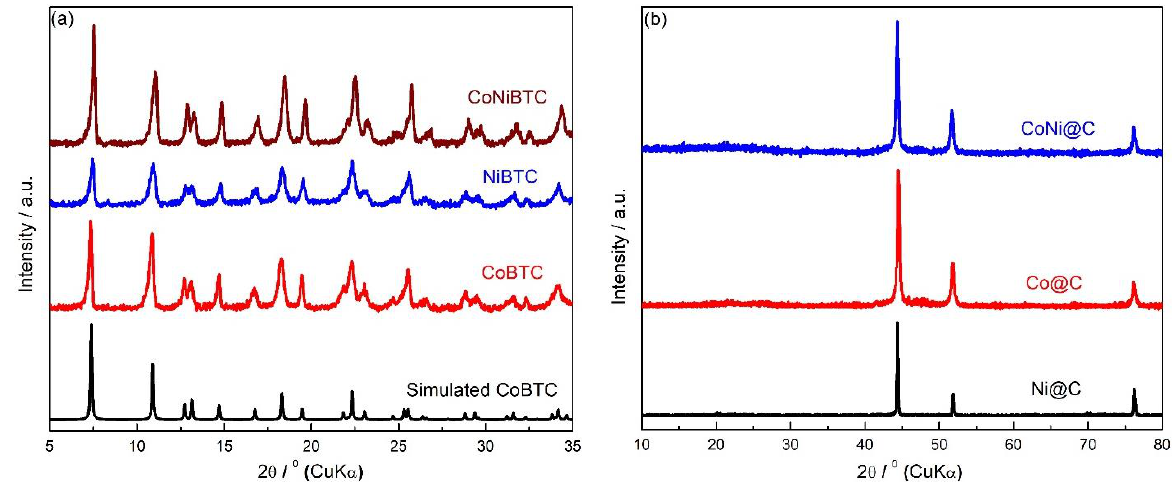
Figure 1. Pxrd of ( a ) CoNiBTC, CoBTC, and NiBTC; ( b ) CoNi@C, Ni@C, and Co@C.